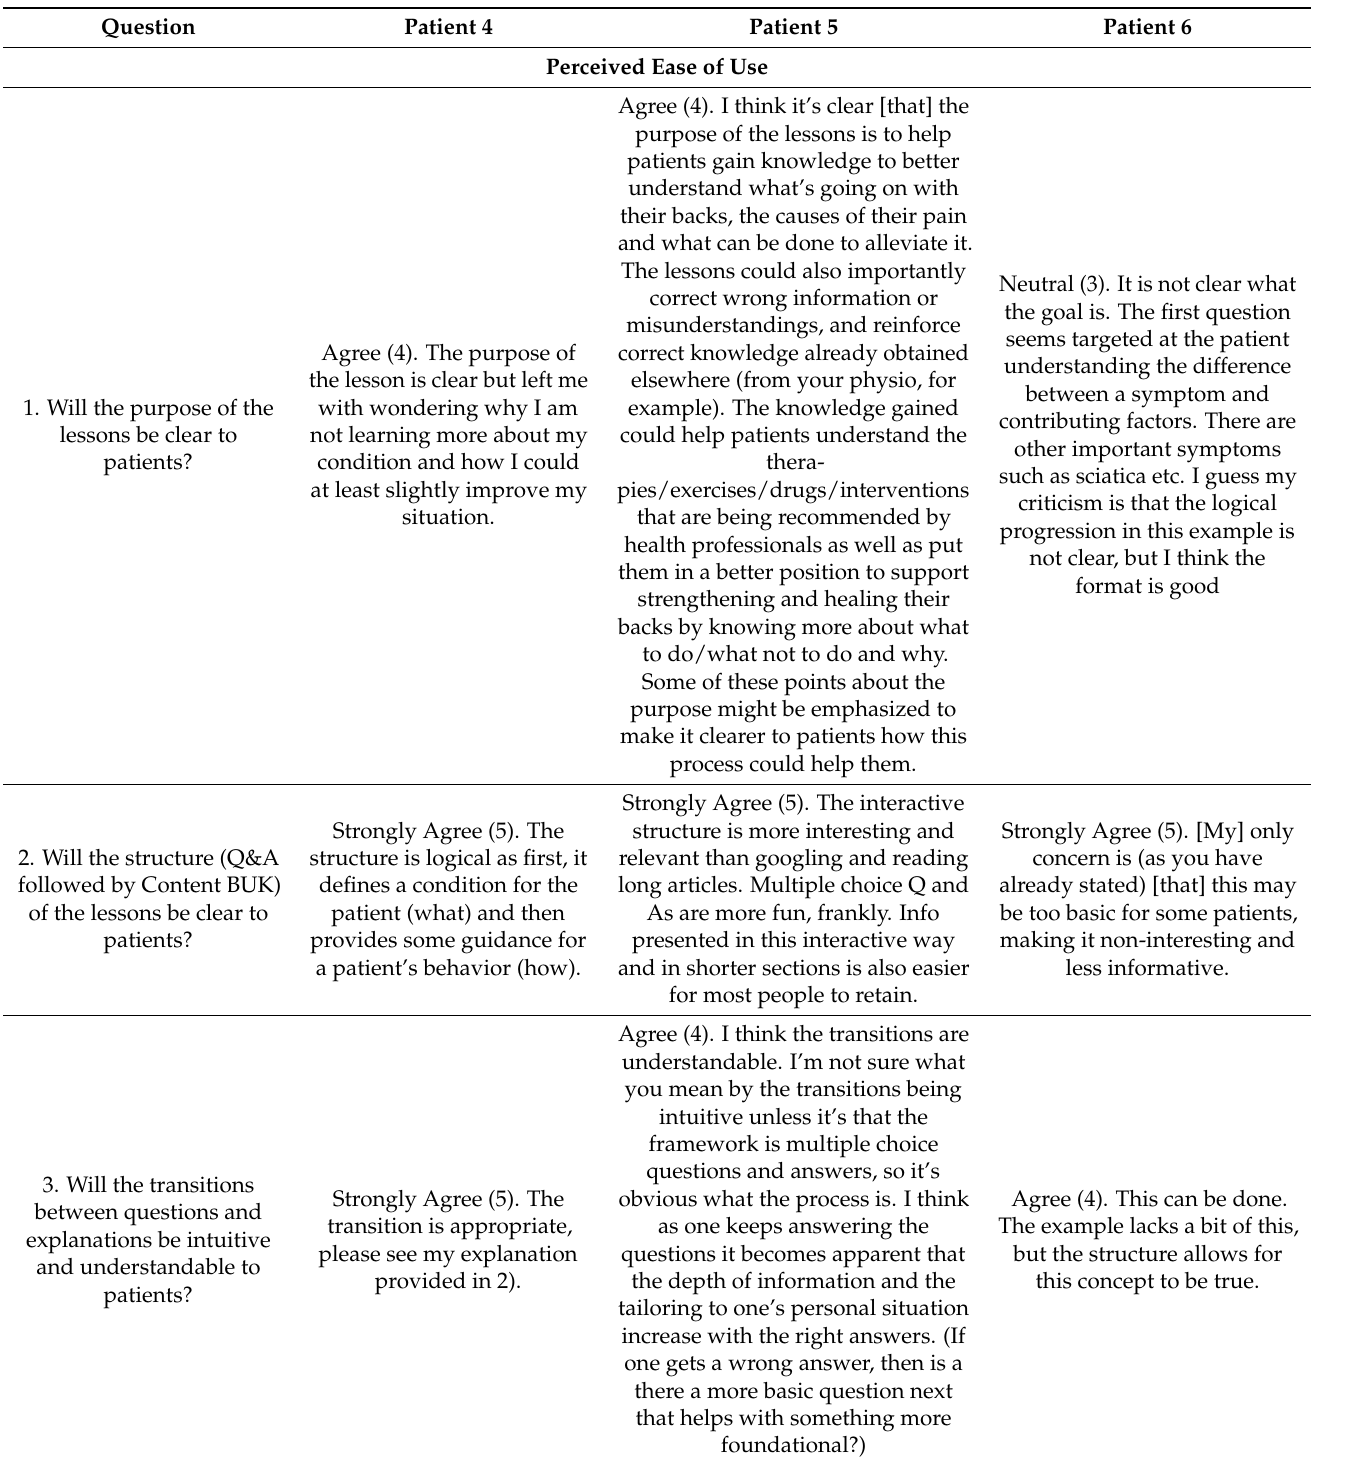
Table A3. User-centered design: feedback received from patient representative end-users’ group for the lower back pain scenario and a low comprehension